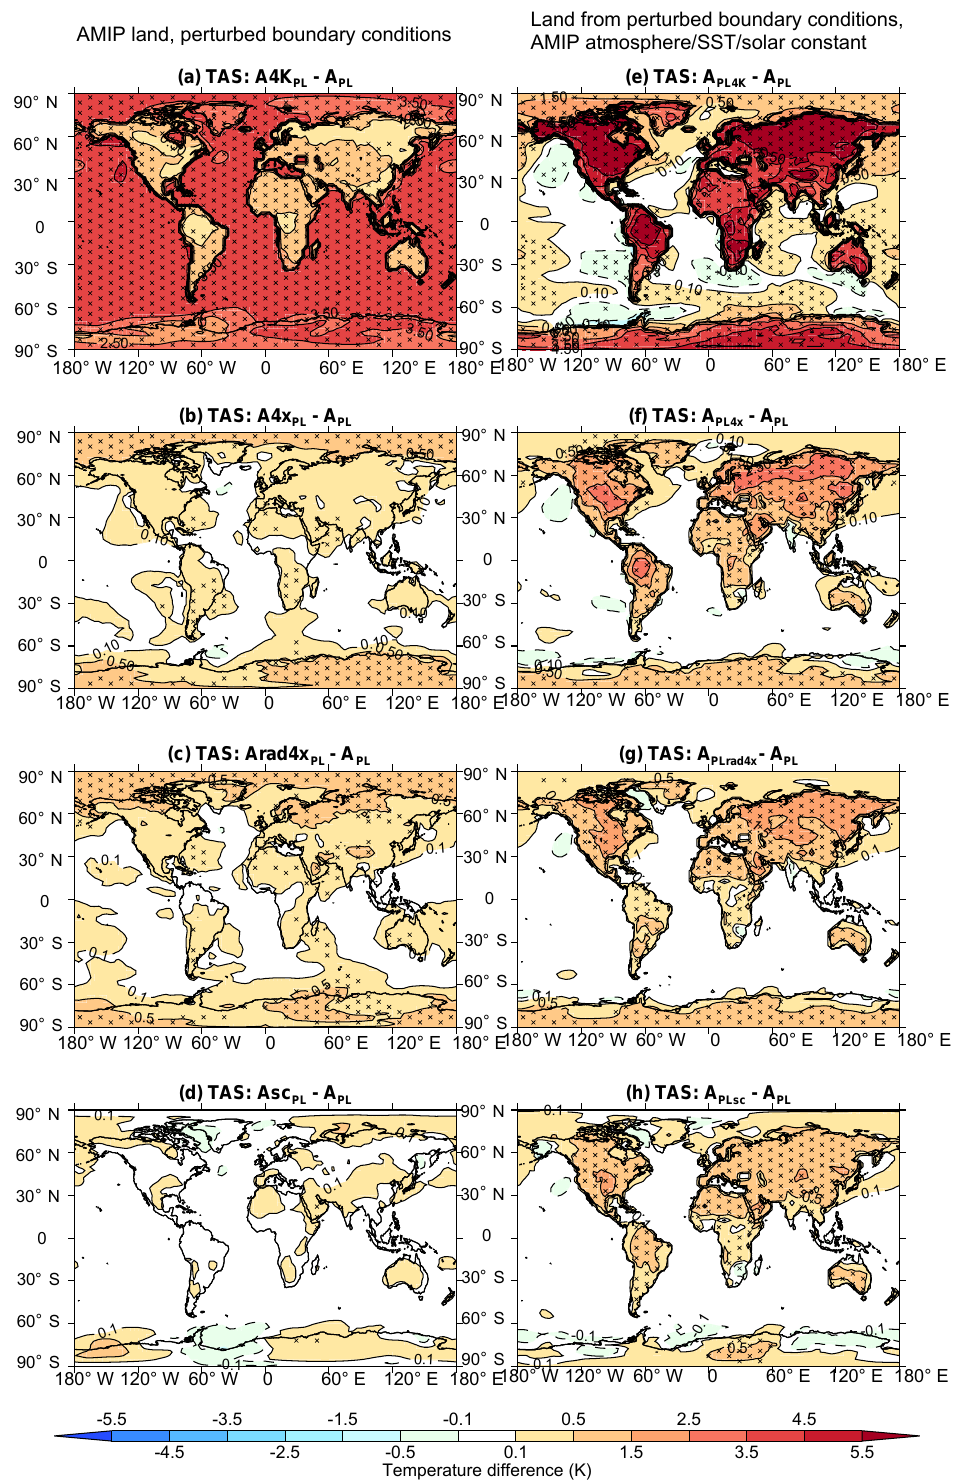
Figure 4. Differences in surface air temperature (TAS, K) for (a) A4K PL minus A PL , (b) A4x PL minus A PL , (c) Arad4x PL minus A PL , (d) Asc PL minus A PL , (e) A PL4K minus A PL , (f) A PL4x minus A PL , (g) A PLrad4x minus A PL , and (h) A PLsc minus A PL . The points labelled with an “x” indicate the differences are statistically significant using Student’s t test ( p ≤ 0 .